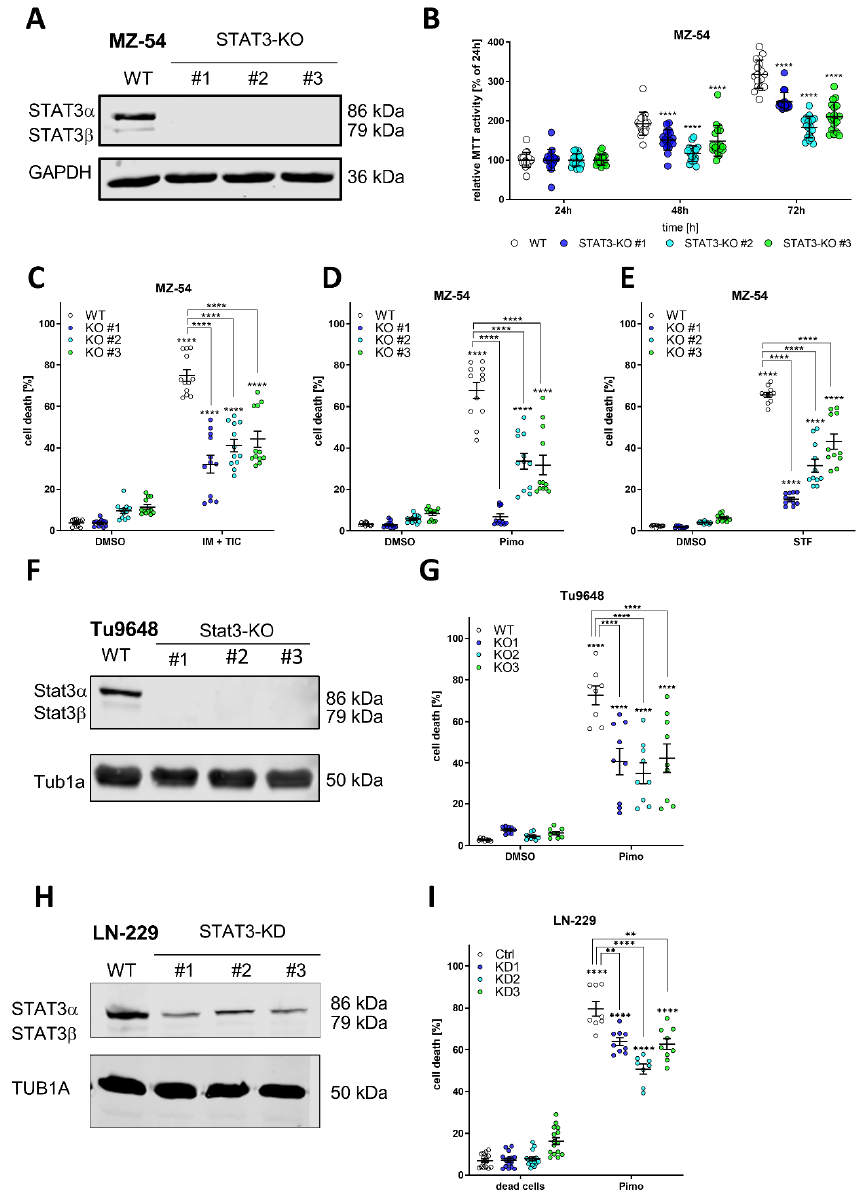
Figure 1. Depletion of STAT3 protects GBM cells from autophagy-dependent cell death. ( A ) Western Blot of STAT3 after Crispr/Cas9-mediated knockout (KO) of STAT3 in MZ-54 human GBM cells showing complete absence of detectable STAT3 in the KO cell lines. GAPDH served as a housekeeping protein. ( B ) MTT cell proliferation assay showing reduced growth rate of STAT3-KO cell lines compared to WT. ( C – E ) ADCD inducers triggered non-apoptotic cell death that could be reversed by complete loss of STAT3. MZ-54 WT and STAT3-KO cells were treated with ( C ) 20 µ M imipramine (IM) and 100 µ M ticlopidine (TIC), ( D ) 12.5 µ M pimozide (Pimo) and ( E ) 40 µ M STF-62247 (STF) for 40 h. DMSO was used as vehicle control treatment. Total cell death was determined by subsequent Annexin-V-APC/PI staining and FACS analysis. ( F ) Western Blot of Cripsr/Cas9-mediated KO of Stat3 of the murine GBM cell line Tu9648. ( G ) Tu9648 WT and Stat3-KO cells were treated with 7.5 µ M Pimo for 40 h and cell death was determined. ( H ) Western Blot of LN-299 human GBM cells after stable depletion of STAT3 using shRNA. ( I ) LN-229 Ctrl and STAT3-KD cells were treated with 12.5 µ M Pimo for 40 h and cell death was determined. The data are presented as point plots of at least three experiments performed with 4 replicates. ** p < 0.01; **** p > 0.0001; Two-Way ANOVA with Tukey’s multiple comparison test (GraphPad Prism